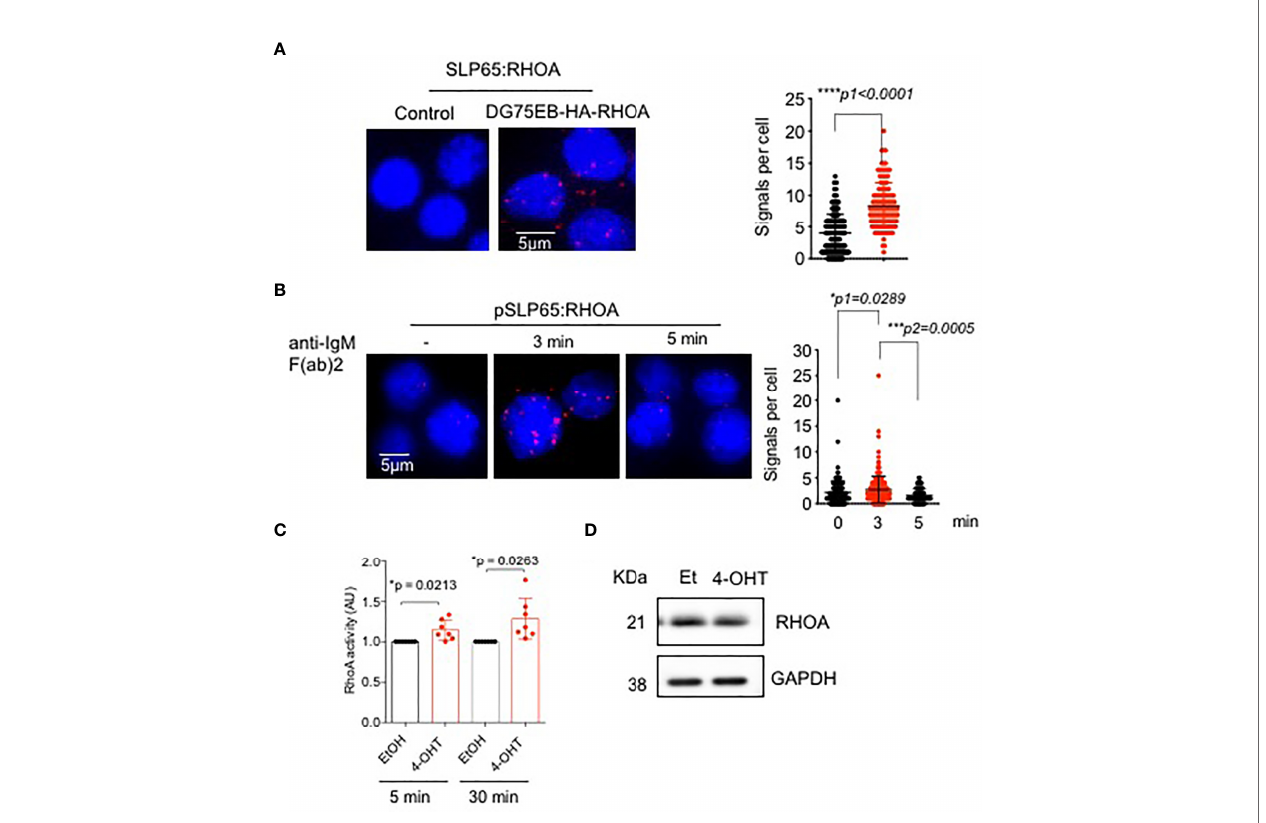
FIGURE 2 | SLP65 interacts with RHOA and regulates its activation. (A) Left- PLA showing the association of SLP65 and RHOA in DG75EB/HA-RhoA cell line. Only secondary antibodies are used in the controls. Close proximity is shown as red dots. Right- quanti fi cation of number of signals per cell, error bars represent mean ± SD. Unpaired t-test, two-tailed. (B) Left- PLA showing the association of RHOA with phosphorylated SLP65 in DG75EB/HA-RhoA cell line upon BCR stimulation. Cells were stimulated with anti-IgM F(ab) 2 antibody for the speci fi ed time period. Right- quanti fi cation of number of signals per cell, bars represent mean ± SD. Unpaired t-test, two-sided. (C) Detection of total cellular RHOA activity by G-LISA RHOA activation assay. Reconstituted bone marrow derived pre B cells from TKO mice were treated with ethanol (control) or 4-OHT to induce SLP65 for the indicated time point. Equal amounts of cell lysates from control and 4-OHT treated cells were used for the assay. Statistical analysis: one sample t test. (D) Western blot analysis for the detection of RHOA upon SLP65 activation in TKO cells. The cells were reconstituted with µ-heavy chain, l 5 and inducible SLP65-ER T2 construct and then induced with 2µM 4-OHT or Et for 30 min to activate SLP65. GAPDH is used as loading control. *p<0.05, ***p< 0,001, ****p<0.0001, ns, not signi fi